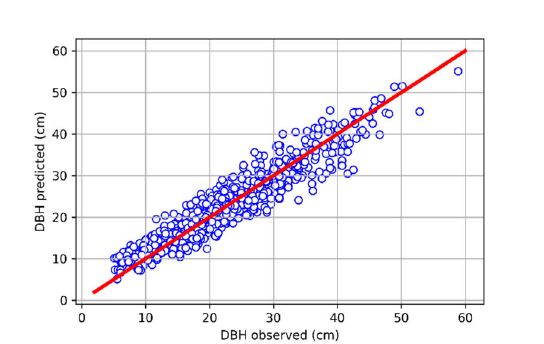
Figure 4 . Plot of the observed/predicted values of DBH for the entire dataset (785 Aleppo pine trees) corresponding to the multivariate allometric model based on Linear Regression (DBH = Φ(H, CD)). Red line refers to 1:1 line.